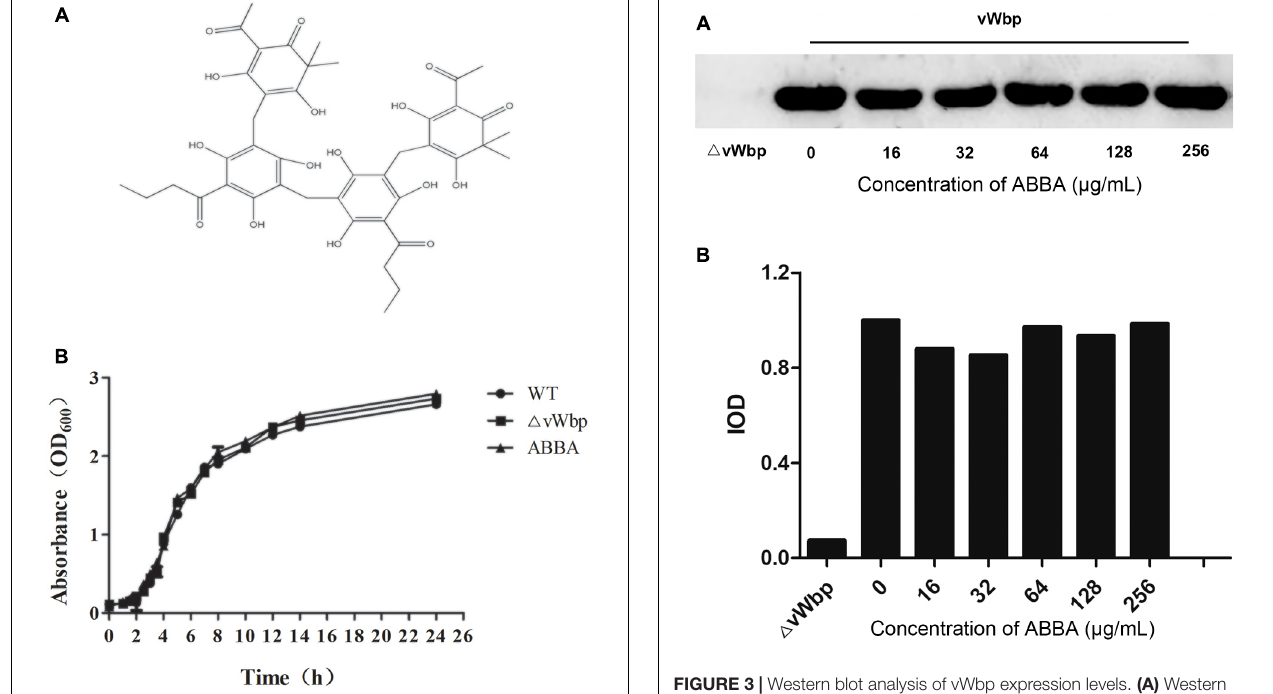
FIGURE 2 | Structure of ABBA (A) and growth curves of S. aureus Newman with or without ABBA (512 µ g/ml) and (cid:49) vWbp (B) .